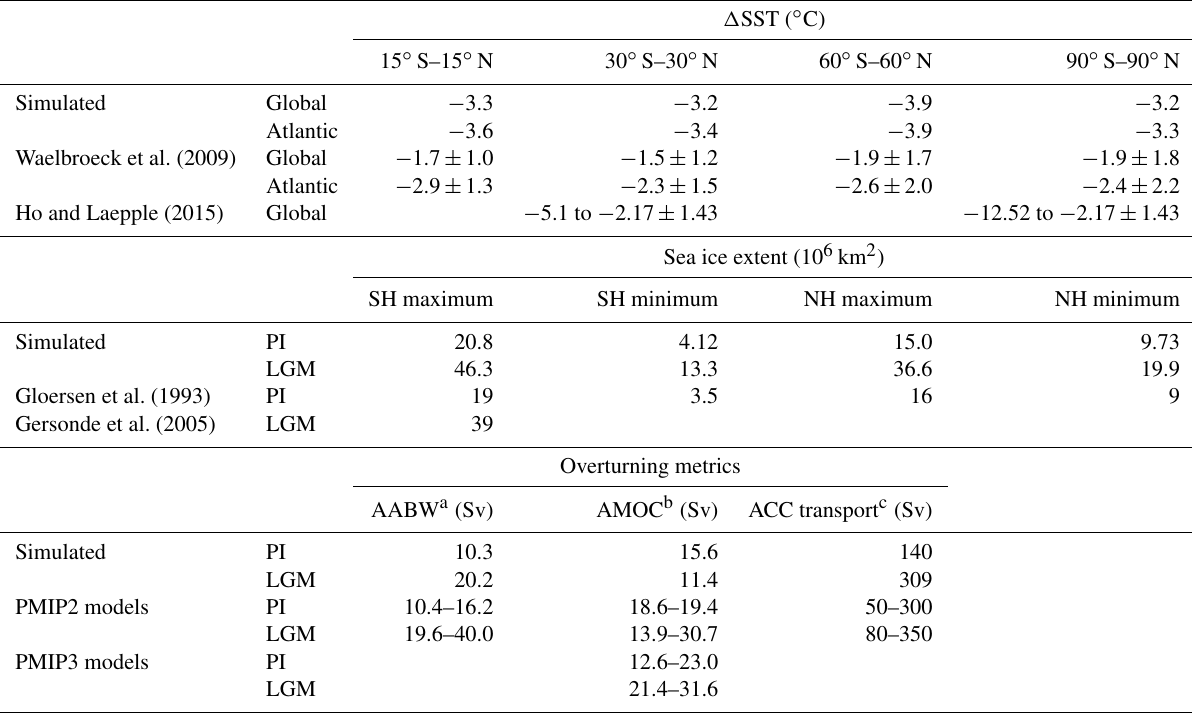
Table 2. Changes in sea surface temperature (SST), sea ice extent and large-scale circulation between the LGM and PI simulations. SST changes are compared with proxy reconstructions of SST generated by Waelbroeck et al. (2009) and Ho and Laepple (2015), who use different proxies for their reconstructions to produce the differences depicted here and discussed in the text. The values of AABW and NADW formation provided by the models from the Palaeoclimate Modelling Intercomparison Project Phase II (PMIP2) are presented by Otto-Bliesner et al. (2007). The transport rate of the Antarctic Circumpolar Current (ACC) for the PMIP2 models is presented by Lynch- Stieglitz et al. (2016). The estimates of NADW production provided by the PMIP3 models were taken from Muglia and Schmittner